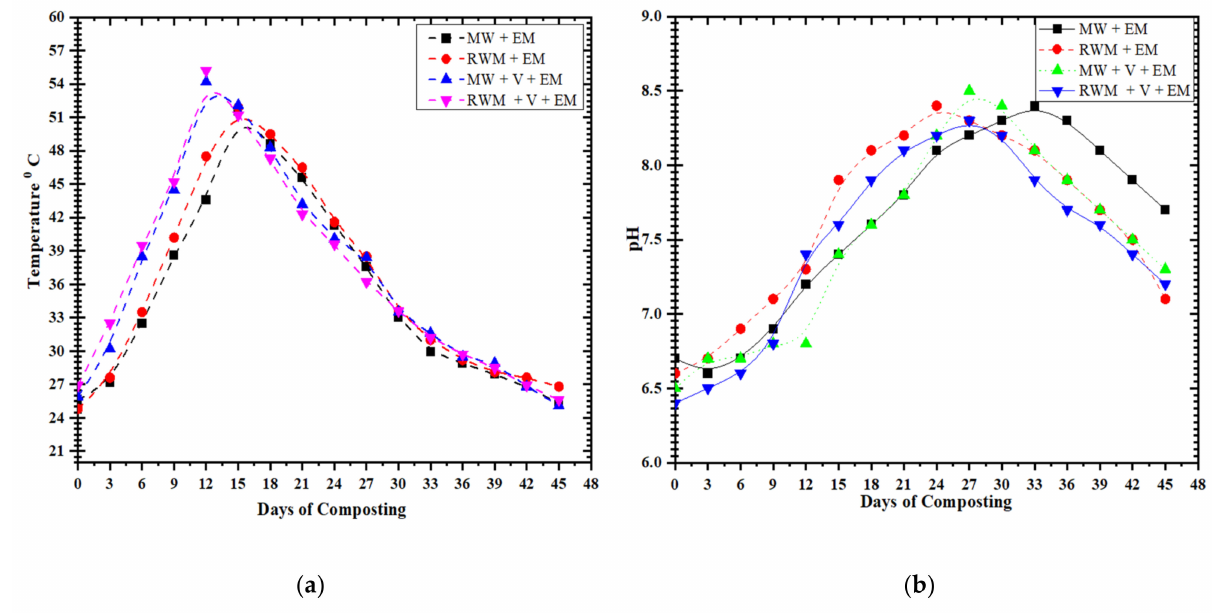
Figure 6. Variation of temperature ( a ) and pH ( b ) changes during composting